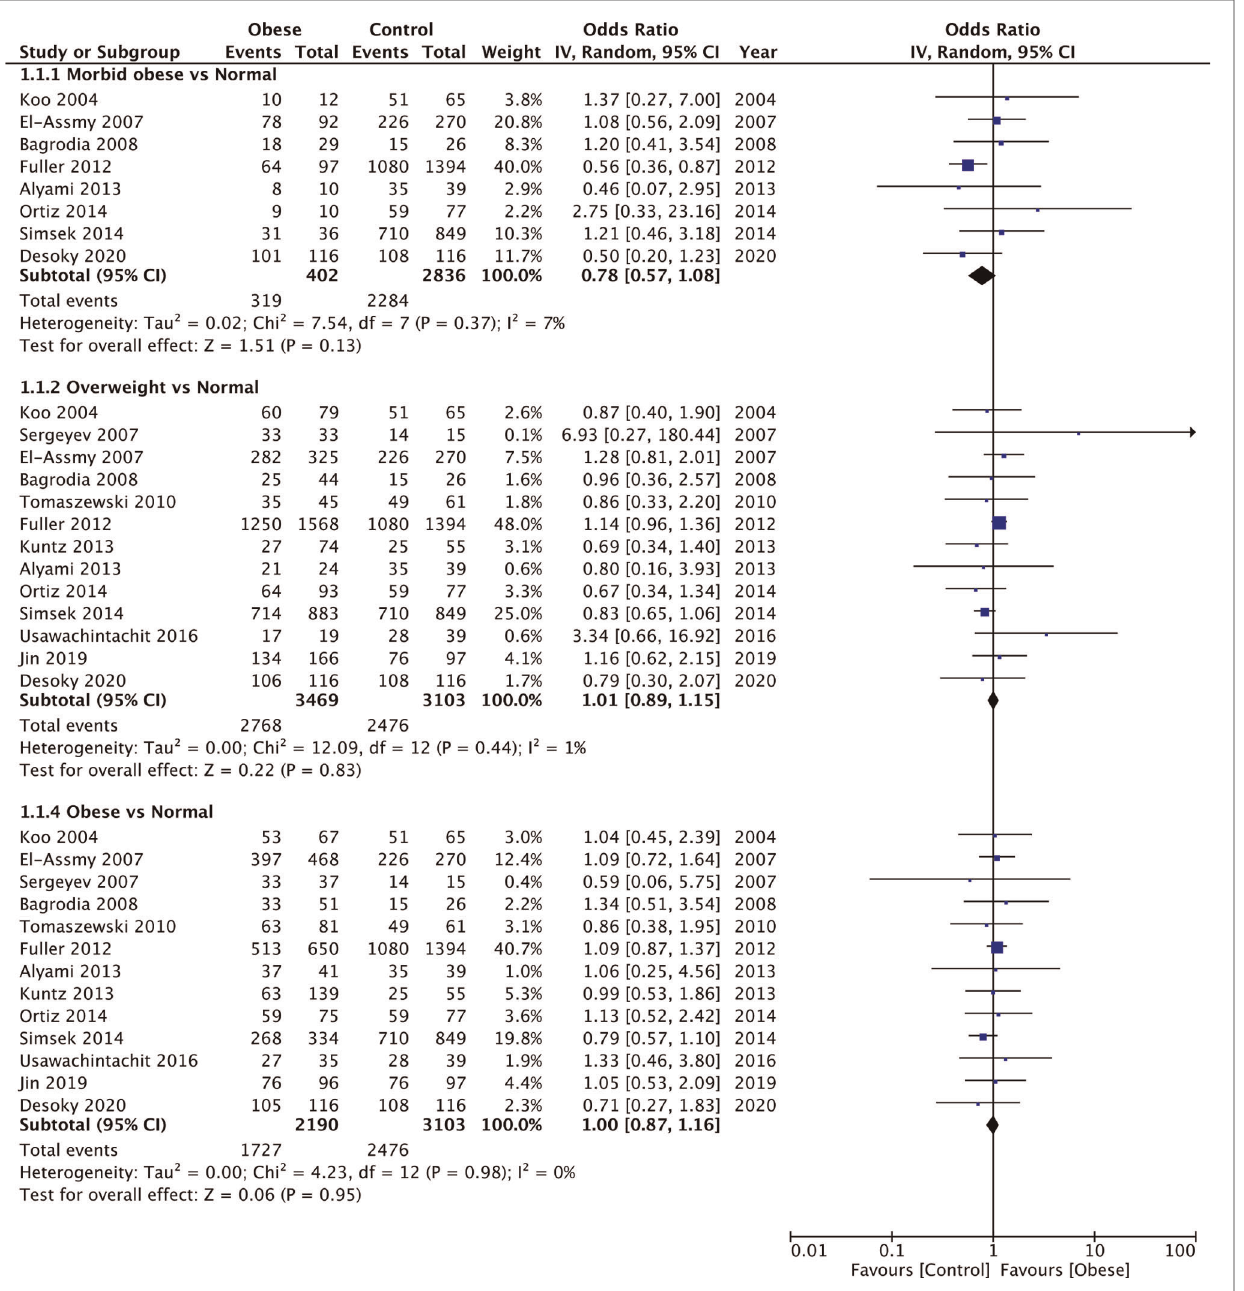
FIGURE 2 | Meta-analysis of stone-free rates between morbid obese, overweight and obese vs normal BMI